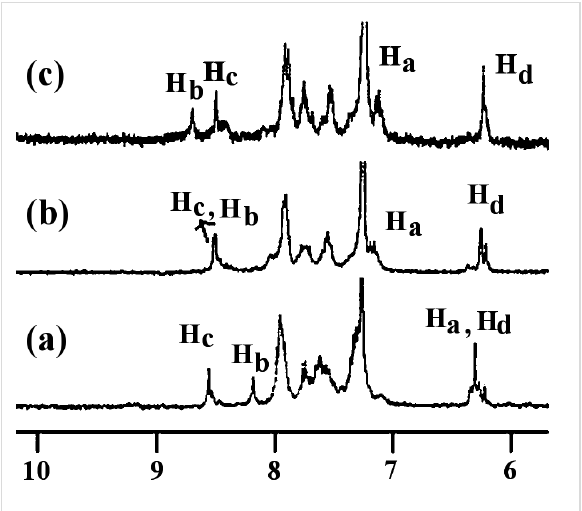
Figure 15: Partial 1 H NMR (300 MHz, CDCl 3 containing 4% CD 3 CN) spectra of (a) 1 ( c = 1.38 × 10 − 3 M), (b) 1:1 and (c) 2:1 (guest:host) complexes with H 2 PO 4 − [see labeled structure 1